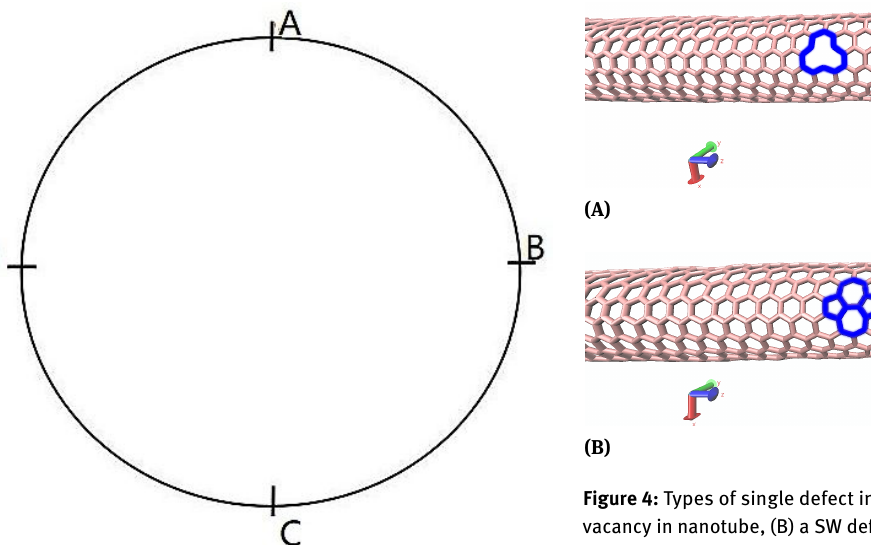
Figure 3: Schematic diagram of the defect position of the inner tube center section